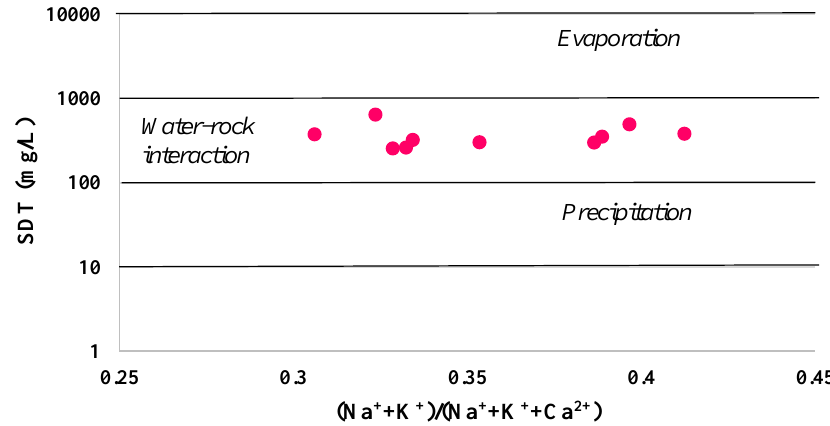
Figure 7. Schöeller diagram of the studied sites.